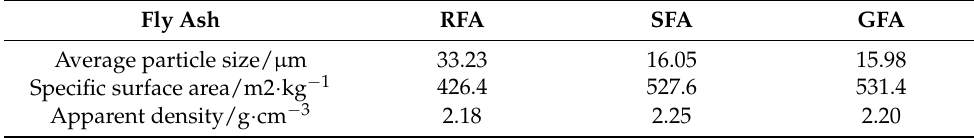
Table 3. Particle characteristic of different fly